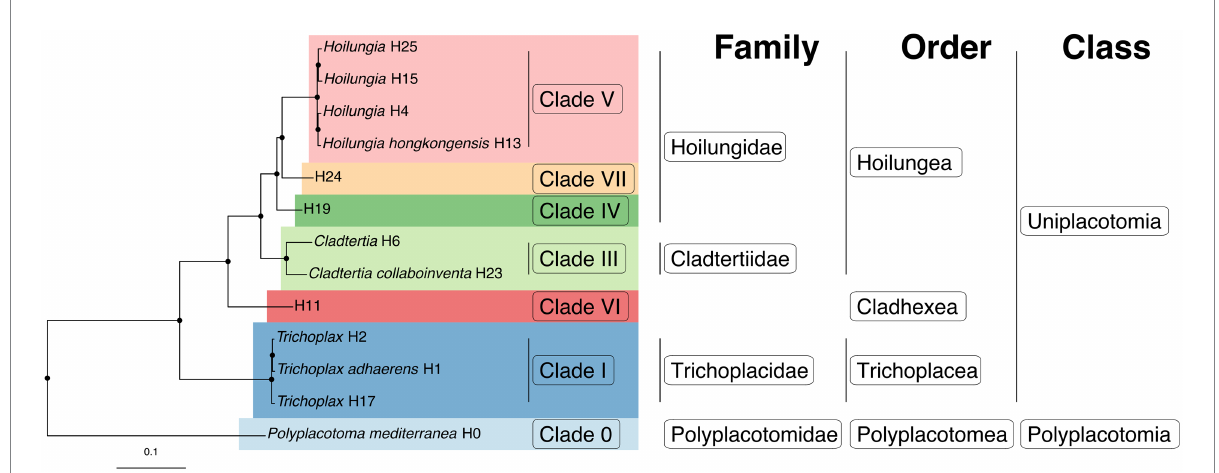
FIGURE 5 The first fully fleshed-out taxonomy for the phylum Placozoa displayed on the likelihood phylogenomic subtree (also see Table 3). Please note that around twice as many species-level lineages have been discovered that are yet to be incorporated into a phylogenomic